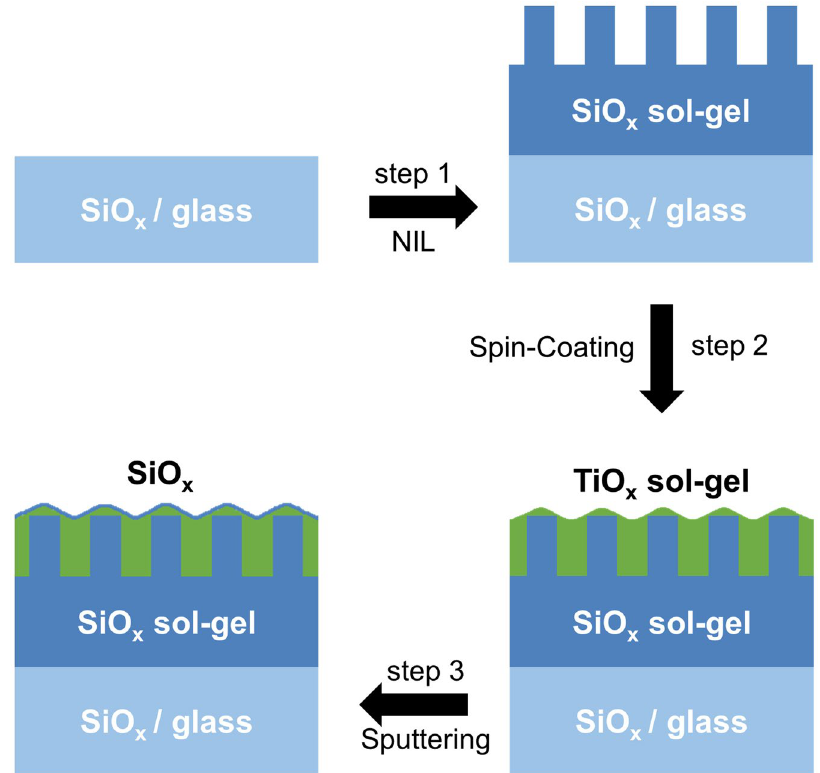
Figure 1. Sketch of the schematic production process of superstrates with a SMART